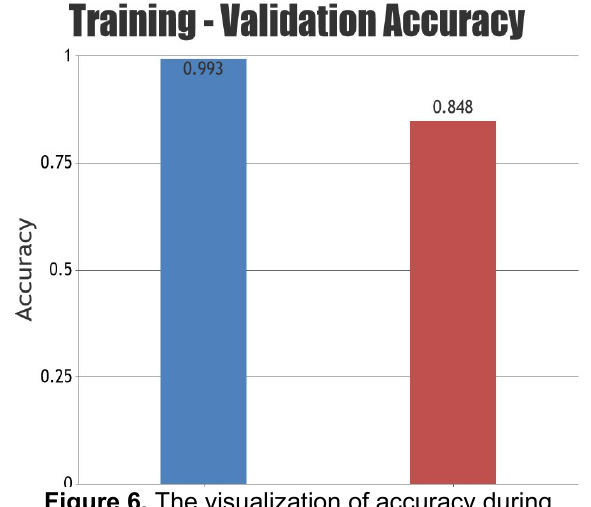
Figure 6. The visualization of accuracy during training.